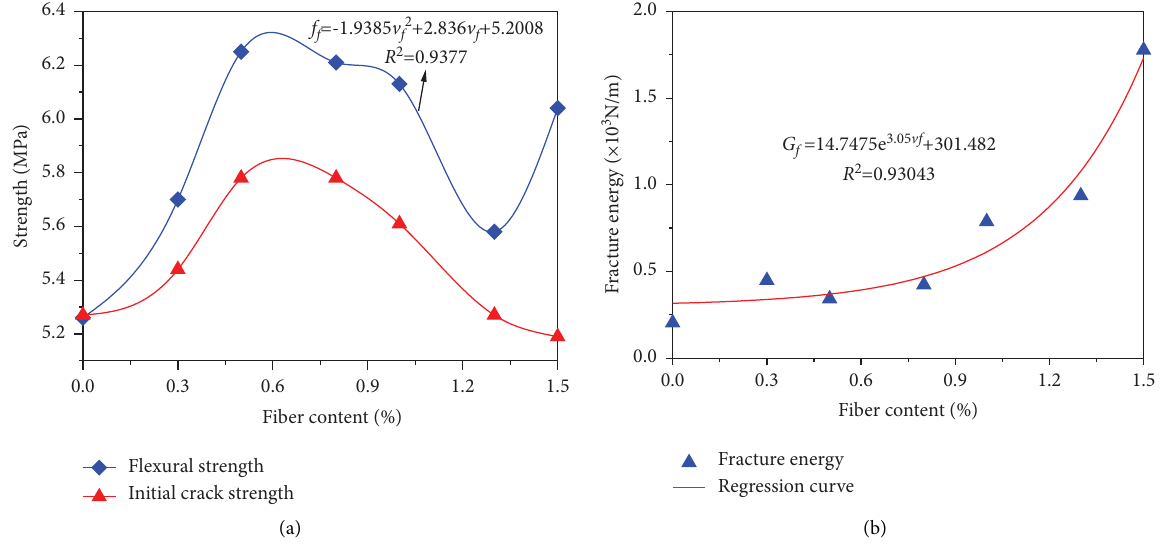
Figure 8: ARGFRC fexural tests: (a) fexural strength and initial crack strength; (b) fracture